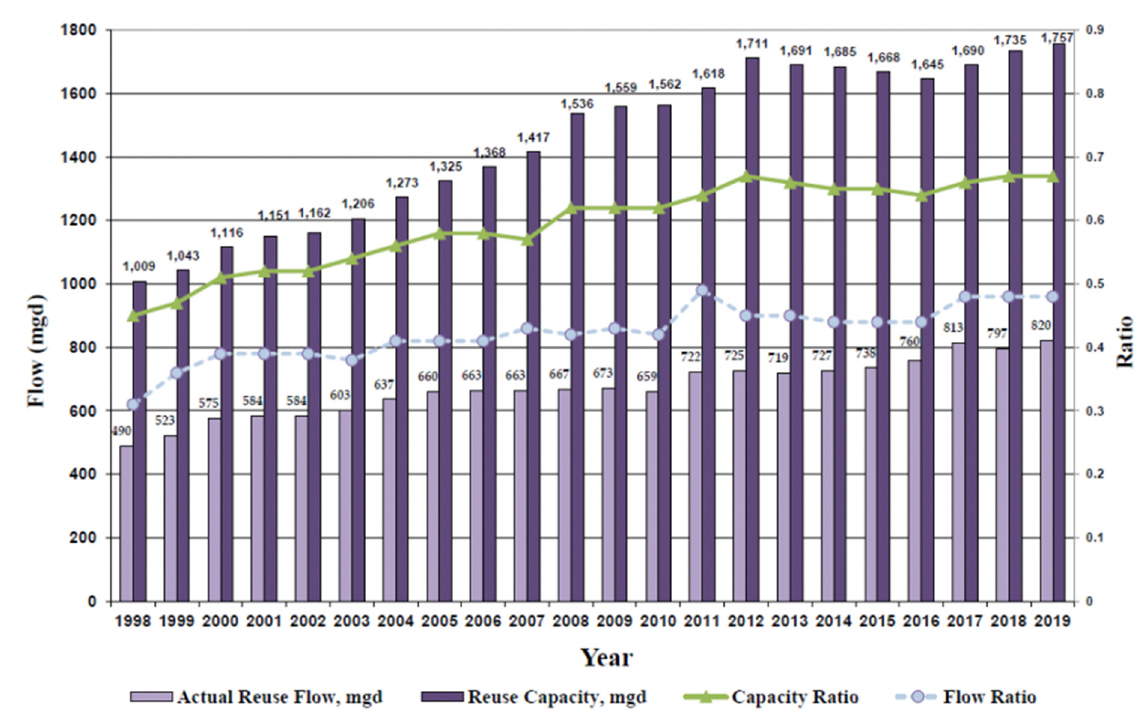
Figure 1. Florida wastewater reuse from 1986 to 2019 [16].